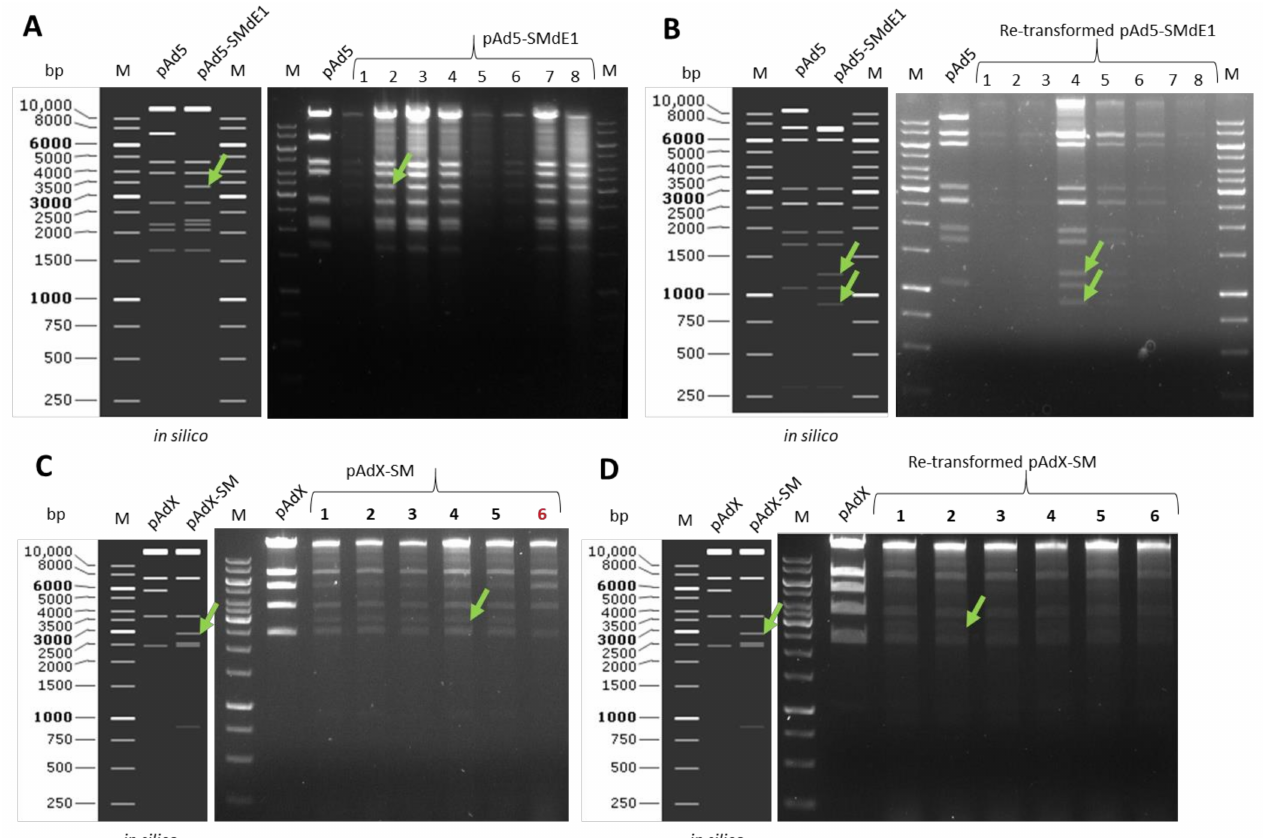
Figure 5. Example of plasmid restriction enzyme digest after positive-selection. Indicated with green arrows are the bands appearing only in positive clones. ( A ). The plasmid digest pattern is exemplified by selection marker (SM) insertion into E1 region of Ad5. The digest of both parental plasmid pAd5 and the aimed plasmid pAd5-SMdE1 with PvuI. All plasmids are positive for SM insertion evidenced from appearance of the 3.4 kb band. These bands with size range 5–10 kb could be contamination of E.coli genome. Therefore, the expected disappearance of ~7 kb band was not assessable. ( B ). The digest of both parental plasmid pAd5 and the aimed plasmid pAd5-SMdE1 after re-transformation, here the restriction enzyme DraIII was used, all clones were identified as clean-single-type correct plasmid. ( C ). The digest of both parental plasmid pAdX and the aimed plasmid pAdX-SM,